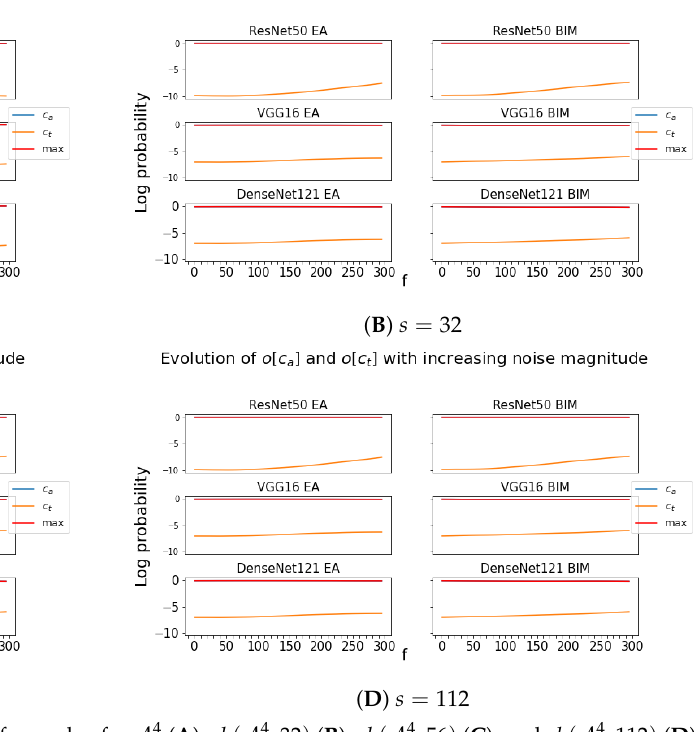
( A ), sh ( A 4 ,32 ) ( B ), sh ( A 4 ,56 ) ( C ), and sh ( A 4 ,112 ) ( D ) when 5 5 5 5 ( A 4 ) and D BIM ( A 4 ) . Along the x axis, the noise is 6 5 5 6